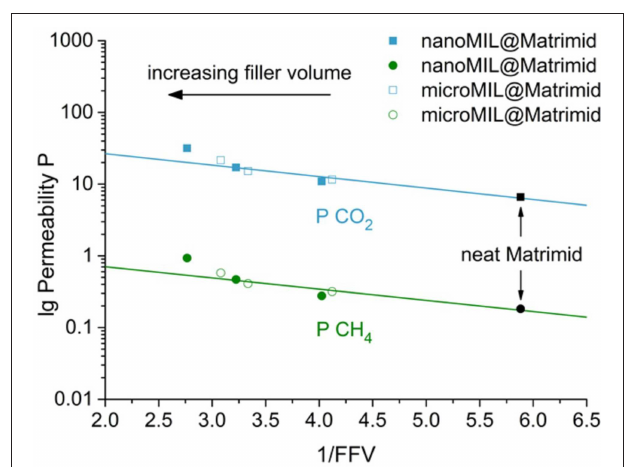
FIGURE 9 | Relative experimental CO 2 permeabilities (referenced to the permeability P c of the pure polymer membrane) for nanoMIL-101Cr@Matrimid (red curve) with different filler volume fraction φ d . The black solid line gives the theoretical CO 2 permeabilities for porous fillers based on the Maxwell Model and the black dashed line gives the theoretical CO 2 permeabilities for porous fillers based on the Bruggeman Model.